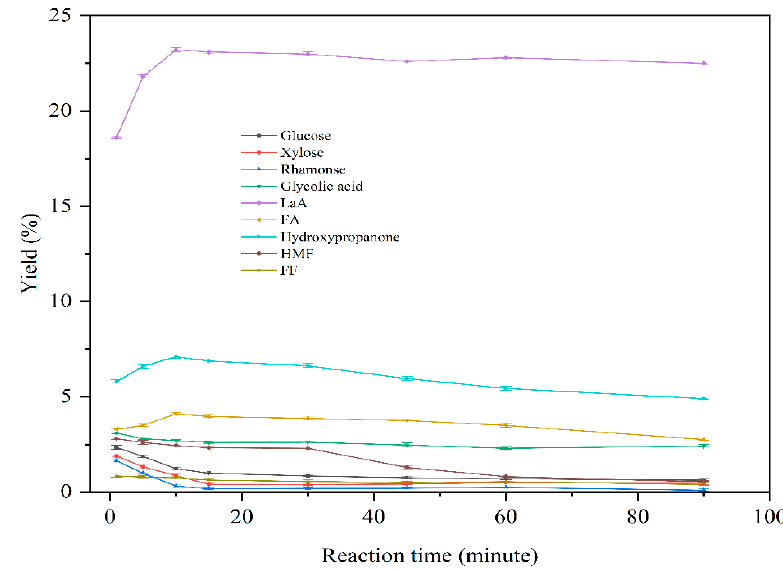
Figure 4. Yields of small molecular products from hydrothermal conversion of U. prolifera at differ- ent reaction time with YCl 3 . Reaction conditions: 1.0 g of U. prolifera , 100 mL water, 13 mmol/L YCl 3 used, 2 MPa N 2 , 200 °C.